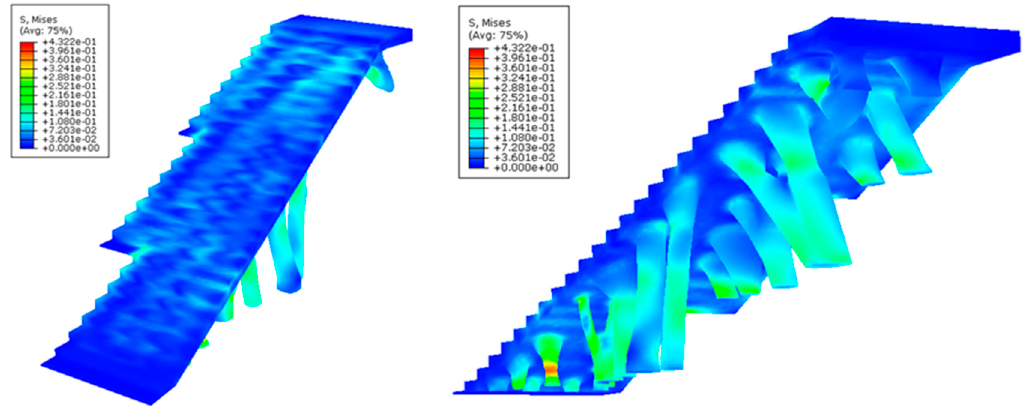
Figure 25. Field of the von Mises stress (MPa) obtained in the mechanical simulations: the BIM building element E 1 indicated in two perspectives in the left and right pictures.